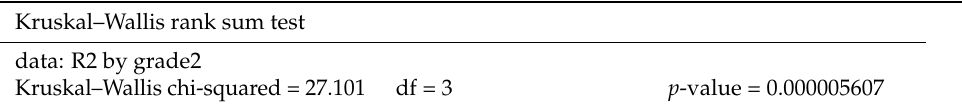
Table 16. Kruskal–Wallis rank sum test for DETAX